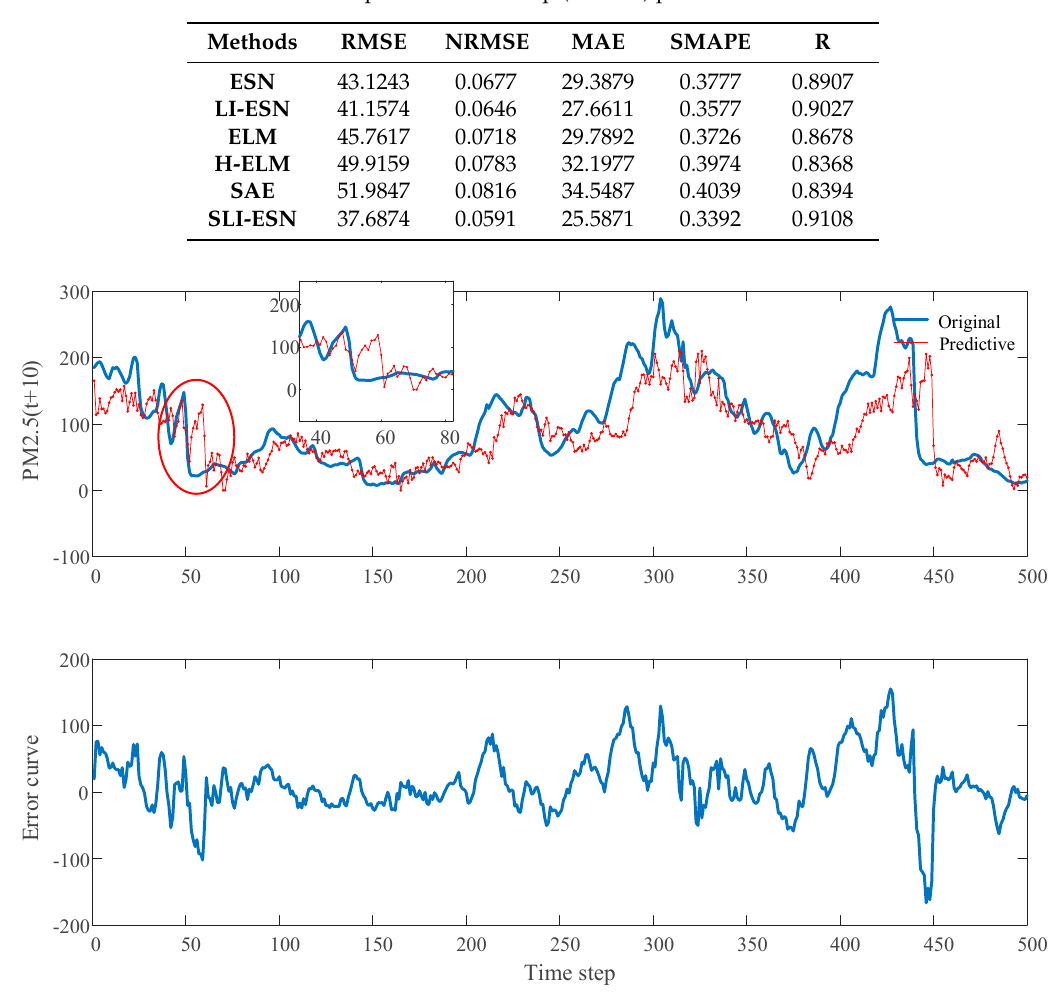
Table 3. Comparison of five-step (5 hours) prediction results.